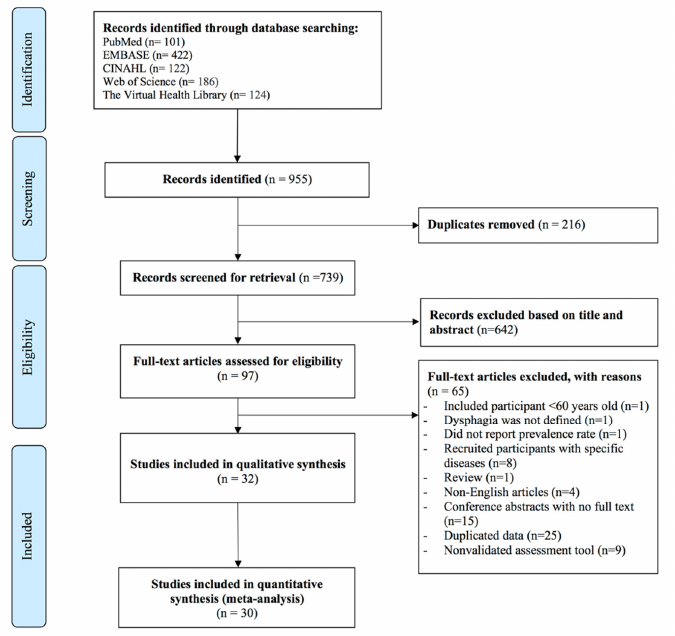
Figure 1. PRISMA Diagram of the Study Selection Process. Figure 1. PRISMA diagram of the study selection